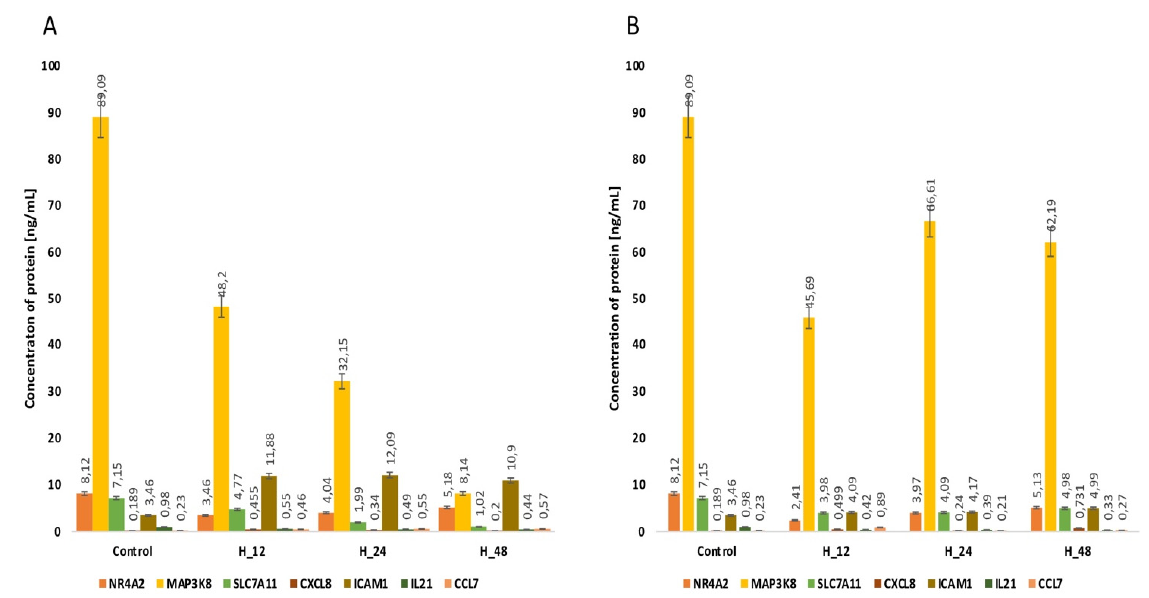
Figure 3. Variances in the concentration of the proteins NR4A2, MAP3K8, CXCL8 and SLC7A11 determined via ELISA assay in the Ishikawa cell line regardless of the time of incubation of endometrial cancer cells with either cisplatin ( A ) or salinomycin ( B ), in comparison with the control. C—control; H_12, H_24, H_48—periods of exposure to cisplatin or salinomycin; NR4A2—nuclear receptor subfamily 4 group A member 2; MAP3K8—mitogen-activated protein kinase kinase 8; CXCL8—C-X-C motif chemokine ligand 8; SLC7A11—solute carrier family 7 member 11; p — p -value. Table 5. Results of the one ‐ way ANOVA and post hoc Tukey’s test for ELISA results.